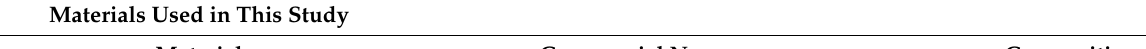
Table 1. List of the materials used during the restorative procedures in this study.